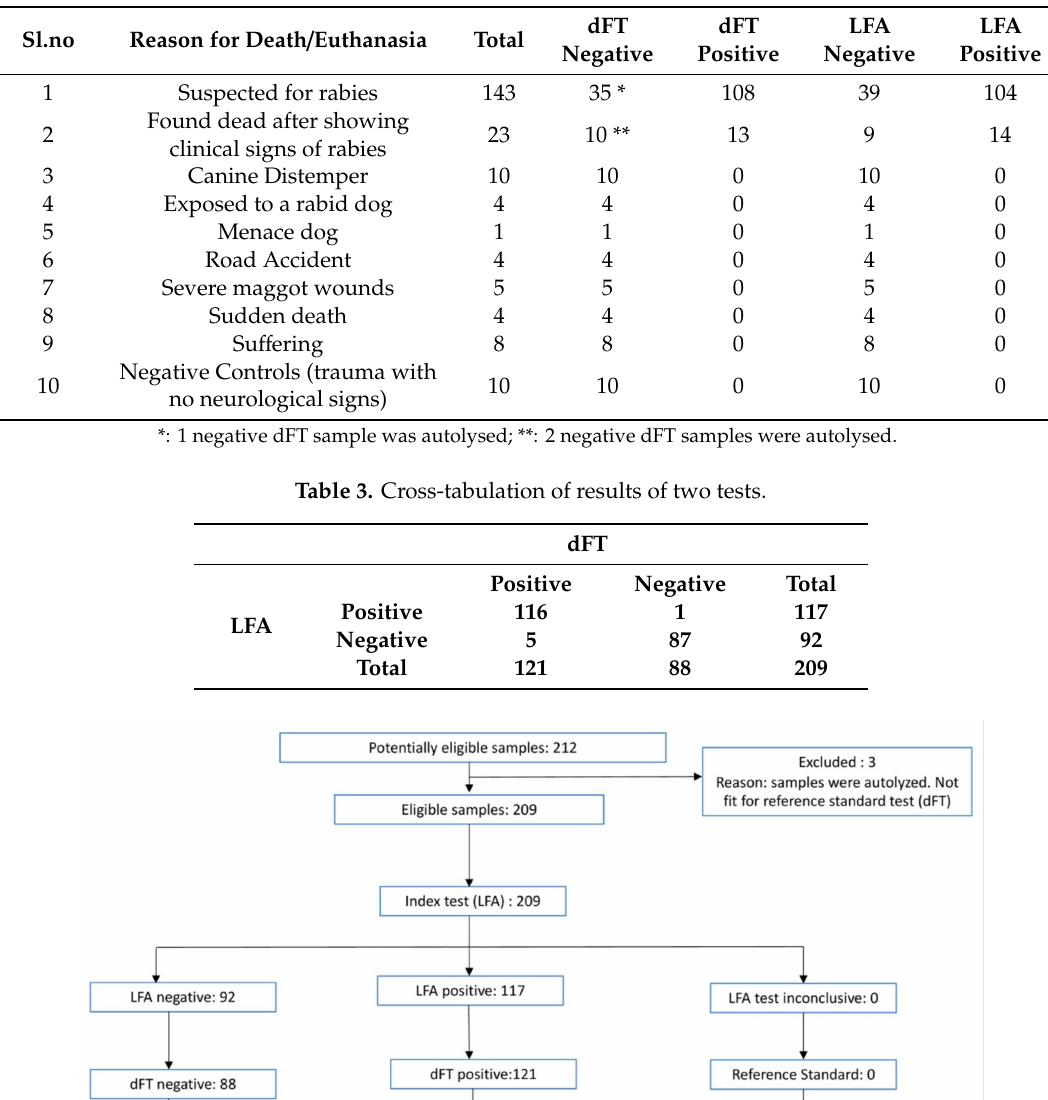
Table 2. Reasons for death / euthanasia of surveillance cases.